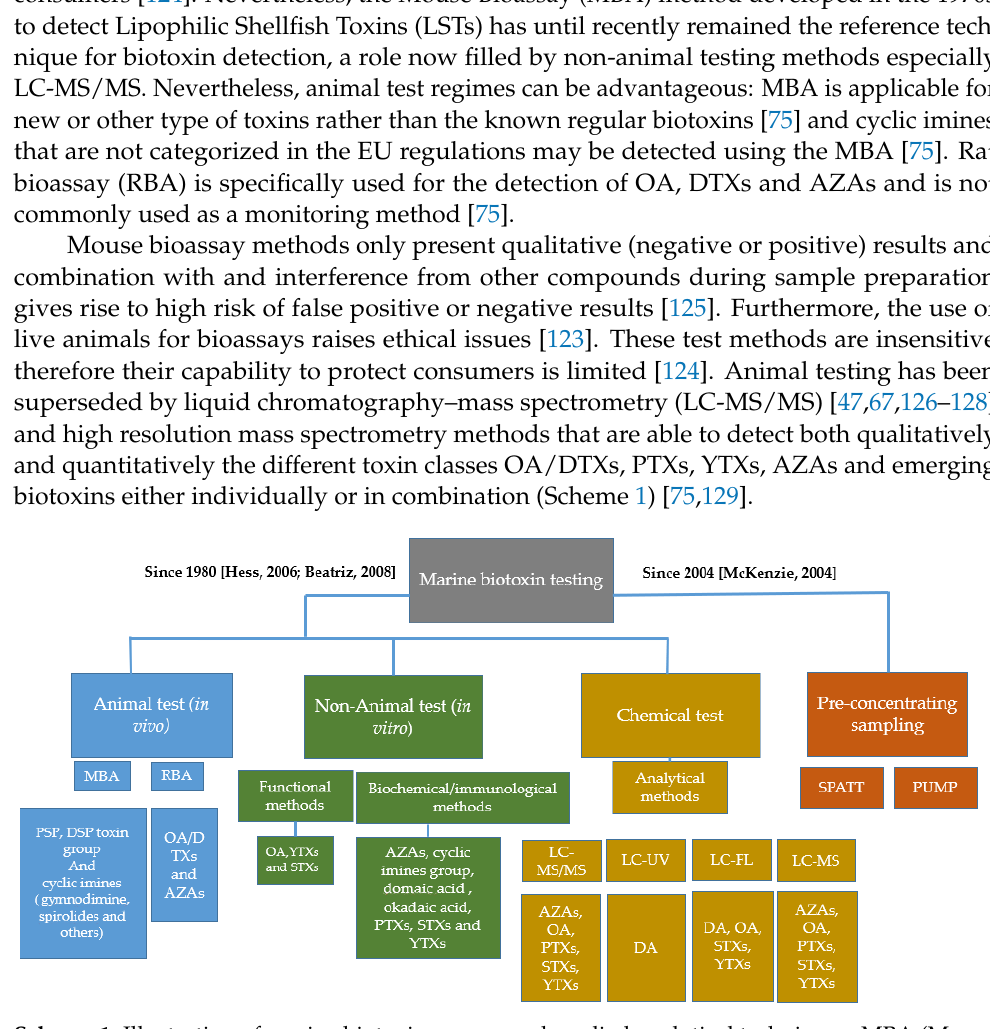
Scheme 1. Illustration of marine biotoxin groups and applied analytical techniques. MBA